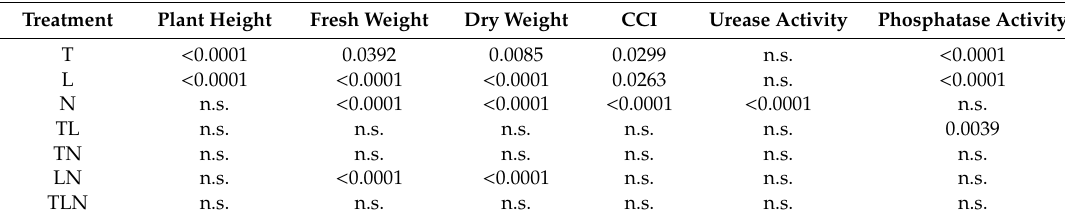
Figure 1. Plant height ( A ), fresh weight ( B ) and dry weight ( C ) of pakchoi under different treatments. Error bars represent the standard error of the means ( n = 3). Bars with different lowercase letters are significantly different according to the Duncan test at p < 0.05. T, L, and N represents photoperiod, photosynthetic photon flux density, and nitrogen supply respectively. Table 3. Three-way ANOVA indicating the effects of independent variables (photoperiod, light intensity and N fertilization) and their interactions on dependent variables with significant p < 0.05.